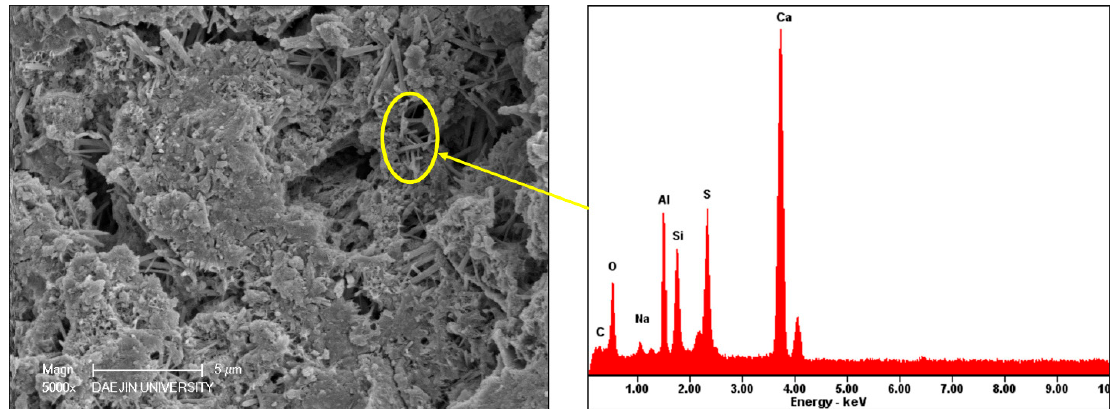
Figure 15. SEM image and EDS analyses of ettringite crystals formed in pores of 12% OPC mortar immersed at 25 °C in 10% Na 2 SO 4 solution.